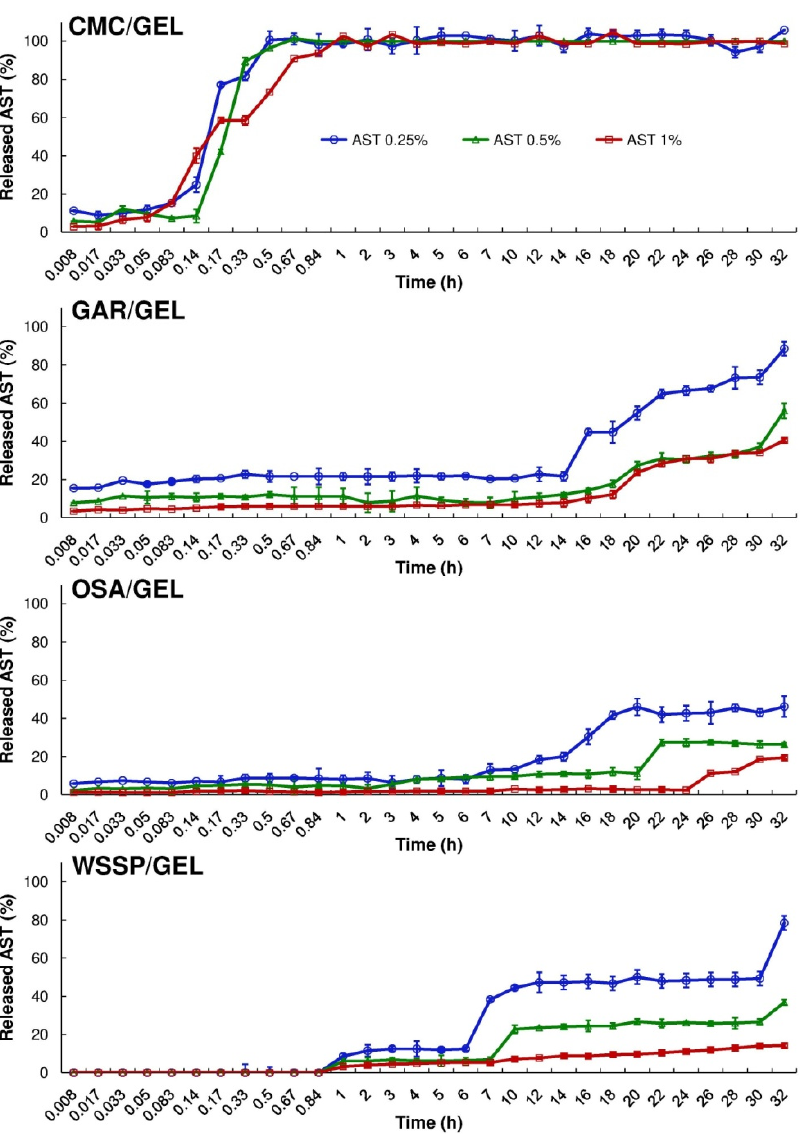
Figure 3. Cumulative migration of AST from the binary polysaccharide/GEL blend films into the water at 25 °C.